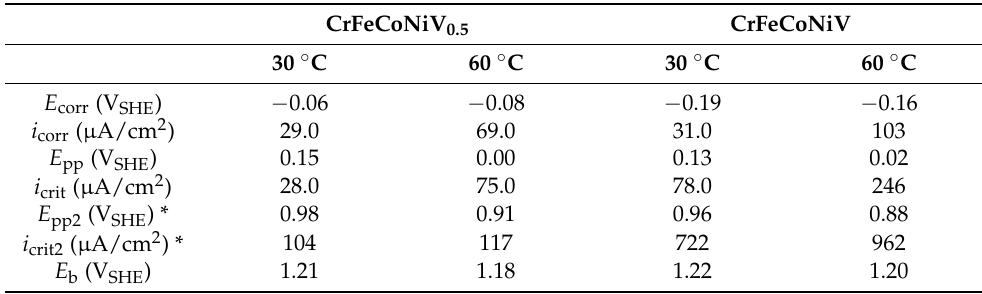
Table 3. Potentiodynamic polarization data of the as-cast CrFeCoNiV x alloys in 1M deaerated H 2 SO 4 solution at different